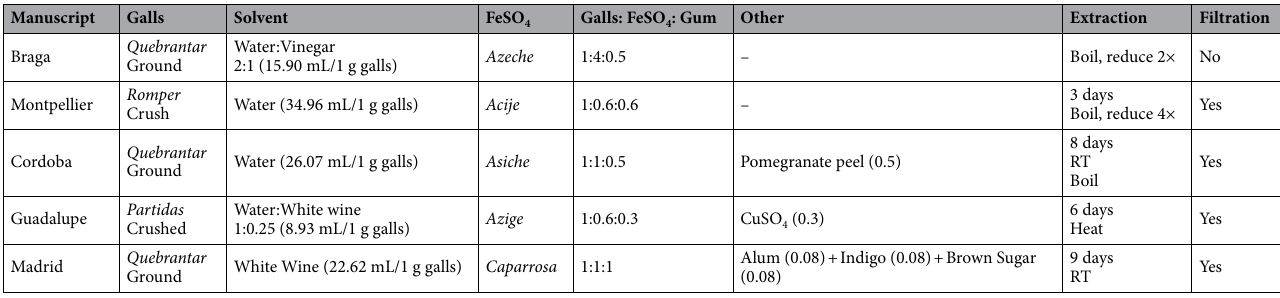
Table 1. Composition and experimental conditions used to prepare the five iron-gall inks from the Iberian treatises (adapted from Ref. 12 ). Original text recipes and transcriptions are available in Supplementary information. All ratios were calculated using the compounds’ mass. RT room temperature.